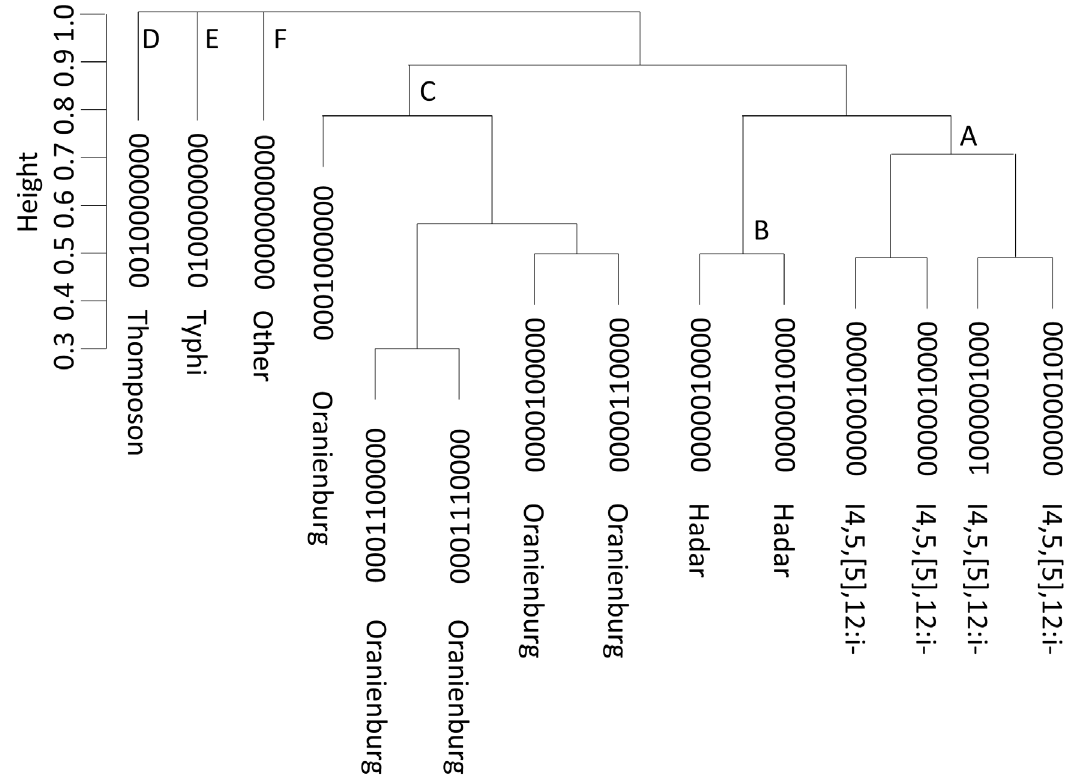
Figure 6. Hierarchical cluster analysis of the 14 subgroups identified from the test dataset using the average linkage distance. The 14 subgroups consist of 5 major subgroups: 1. Thompson (0010000000); 2. Typhimurium (0100000000); 3. Decoy (0000000000); 4.